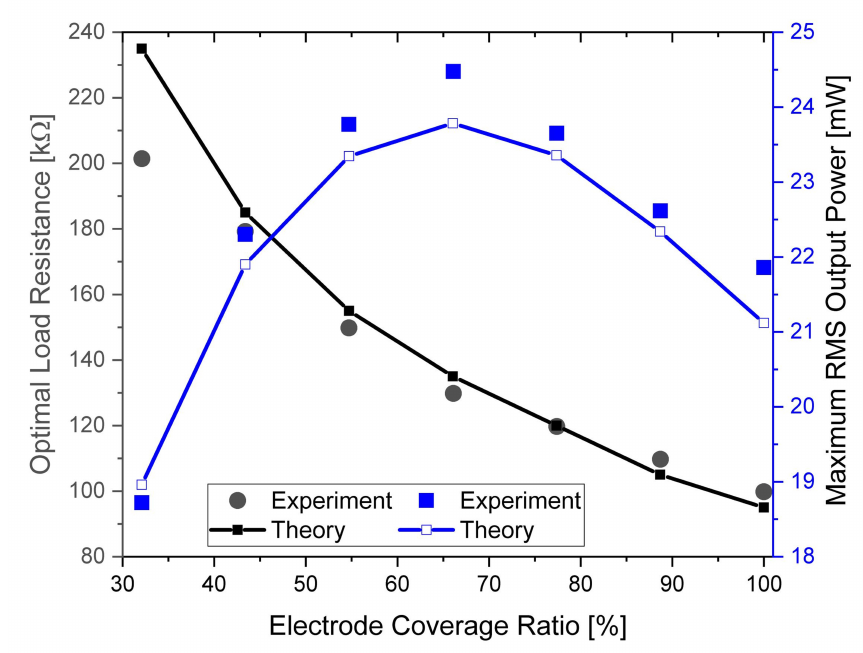
Figure 10. Optimal load resistance and corresponding maximum output power against electrode coverage ratio. The blue line is the output power, and the black line is the optimal load